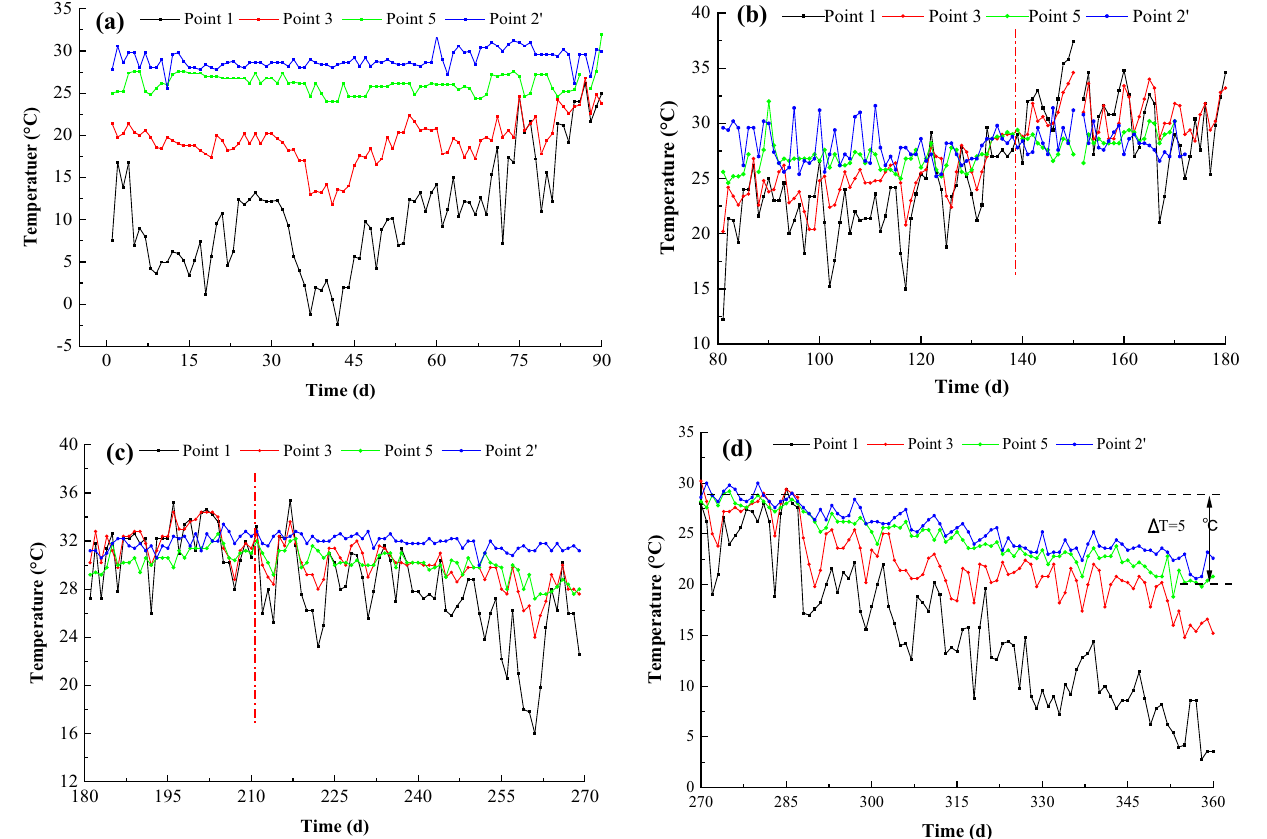
Fig. 6 Effect of surface climate on underground climate in different seasons for the 2302S working face during a the first quarter, b second quarter, c third quarter and d the fourth